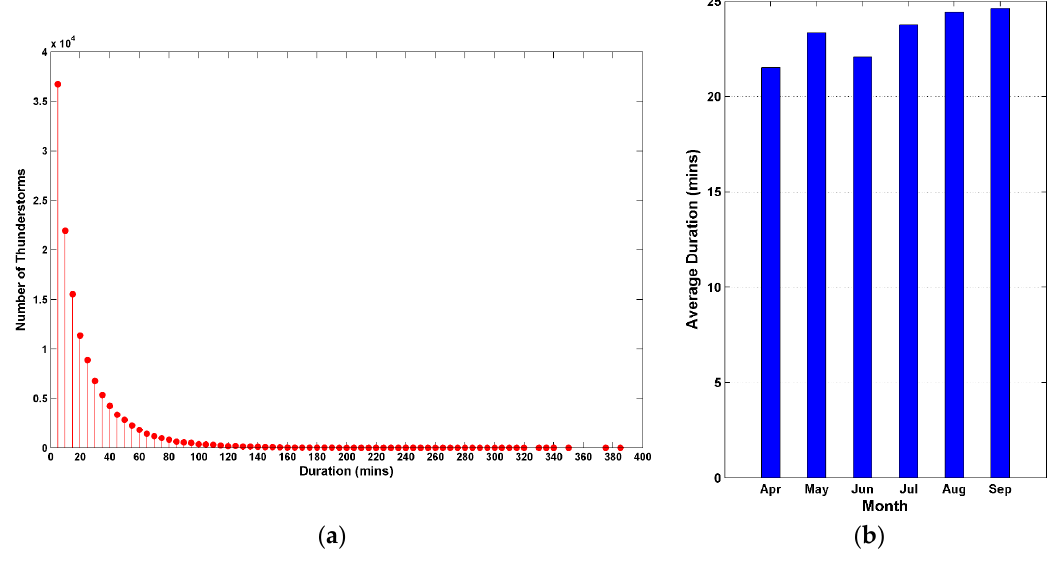
Figure 6. ( a ) Histogram of thunderstorm durations; ( b ) average duration of thunderstorms by month.